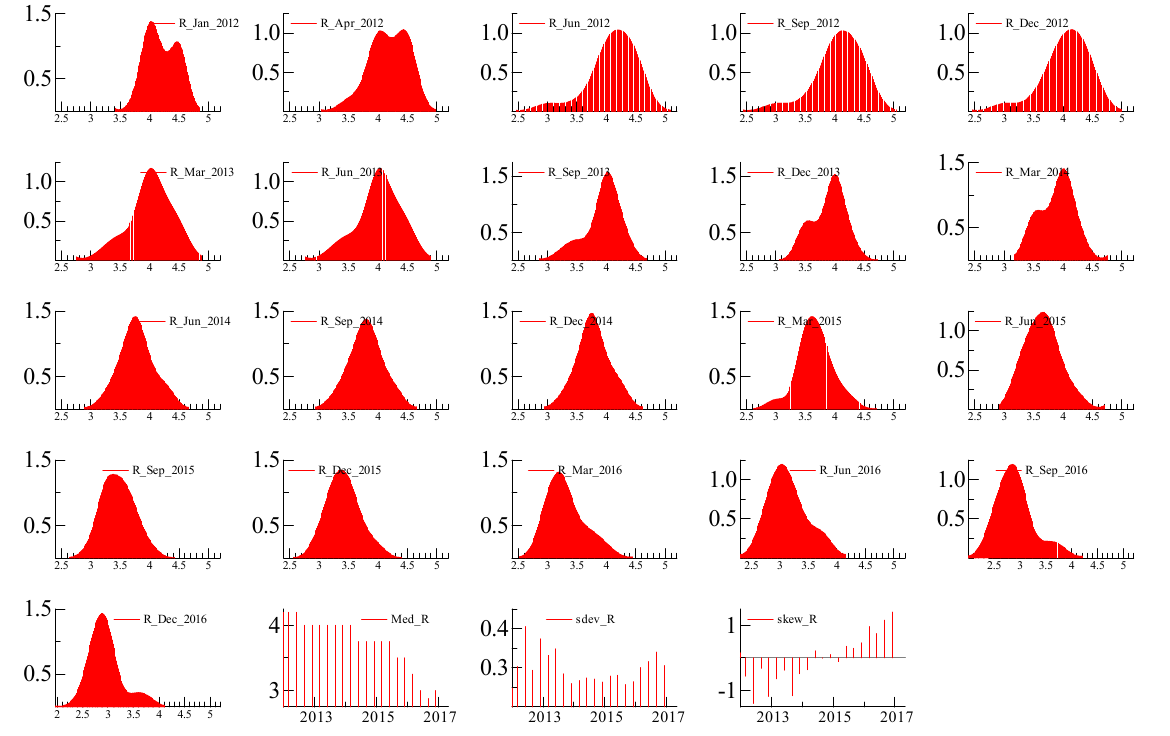
Figure 2. Marginal densities for the FOMC’s longer-run forecast for the Appropriate Interest Rate— January 2012–December 2016. Panels with vertical lines correspond to three moments of the distribu- tions: median, standard deviation, skewness.